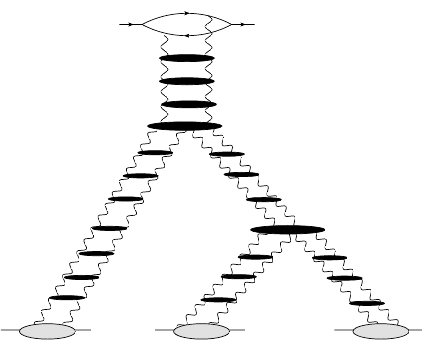
Figure 2 . pomeron fan